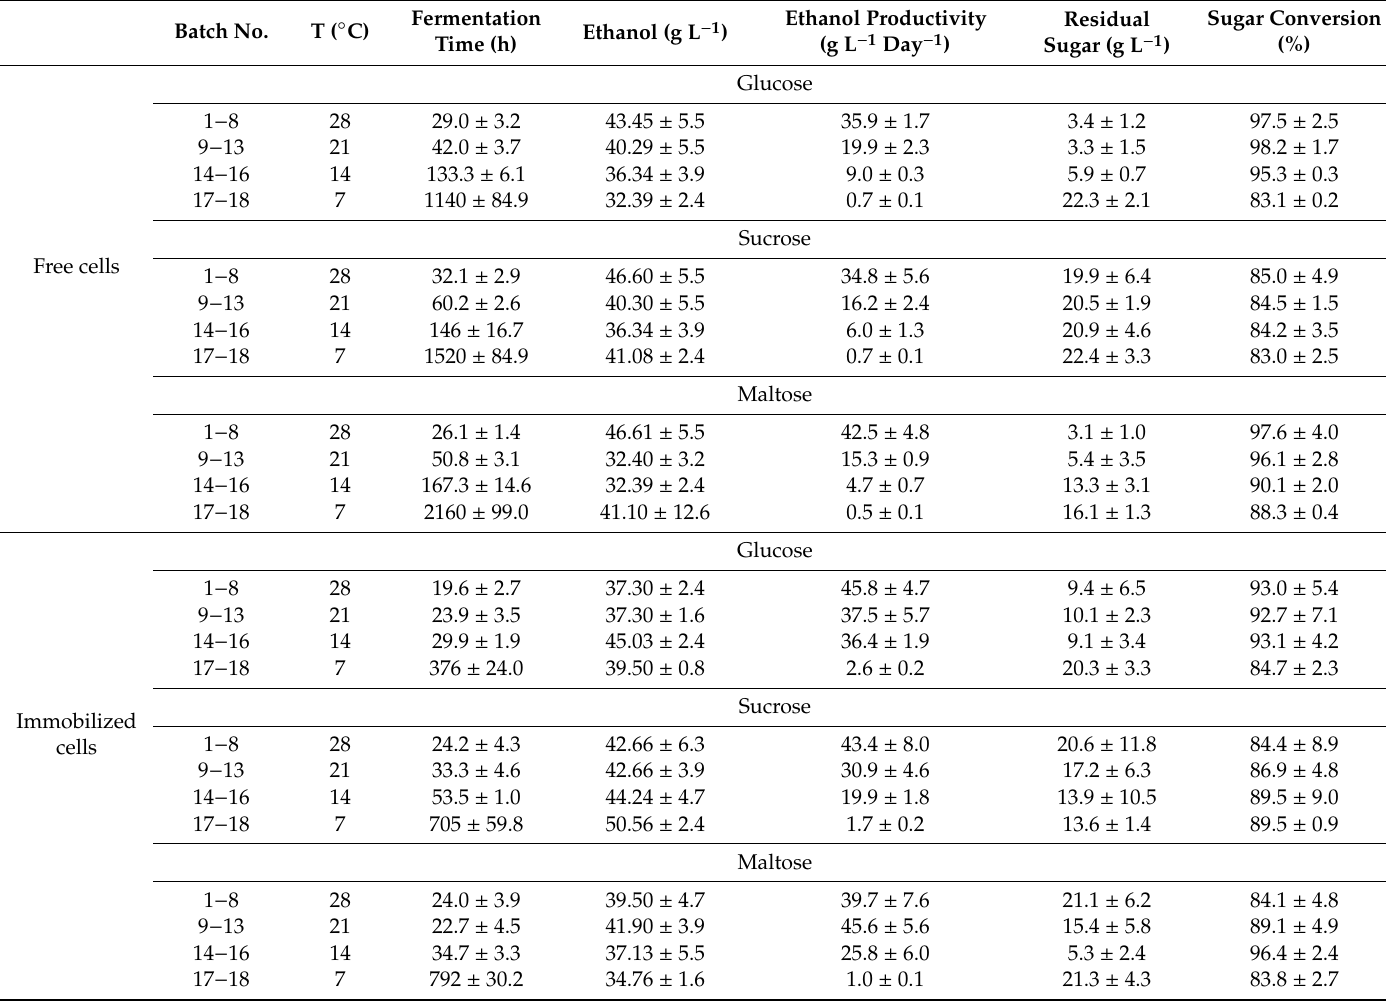
Table 1. Kinetic parameters during fermentation batches of the synthetic medium using free or immobilized yeast cells on P. terebinthus resin at various temperatures. Batch